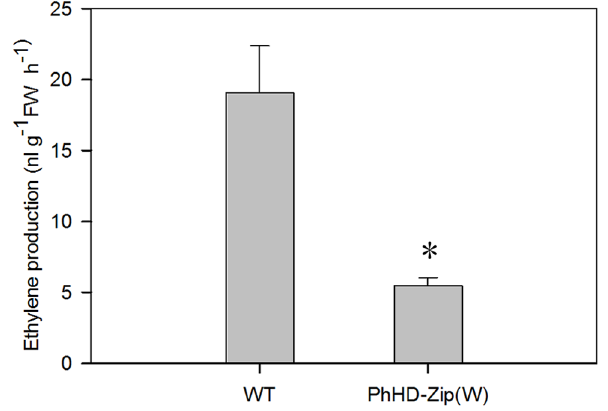
Figure 6. Effect of silencing PhHD-Zip on ethylene production of petunia flowers. Ethylene production was measured at D7 for wild type (WT) and for silenced (white) flowers (PhHD-Zip W). (Asterisks denote statistical difference using Duncan’s test at P , 0.05; n=5, error bars denote SE of the means of five biological replicates).